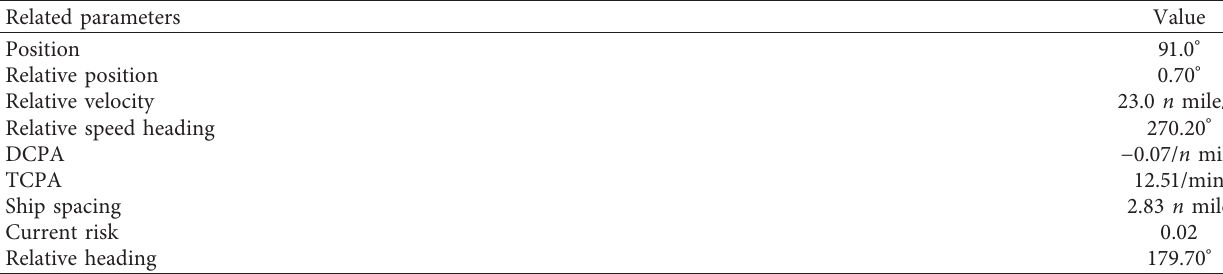
Table 4: Relevant data of encounter scene experiment.